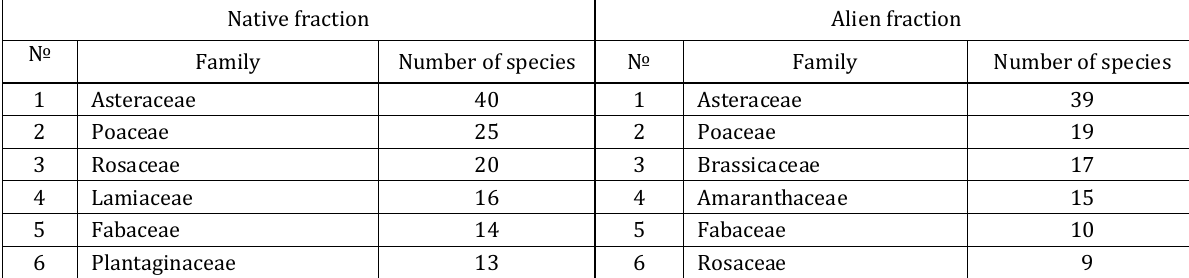
Table 2. The main families of the spontaneous flora of the Botanical